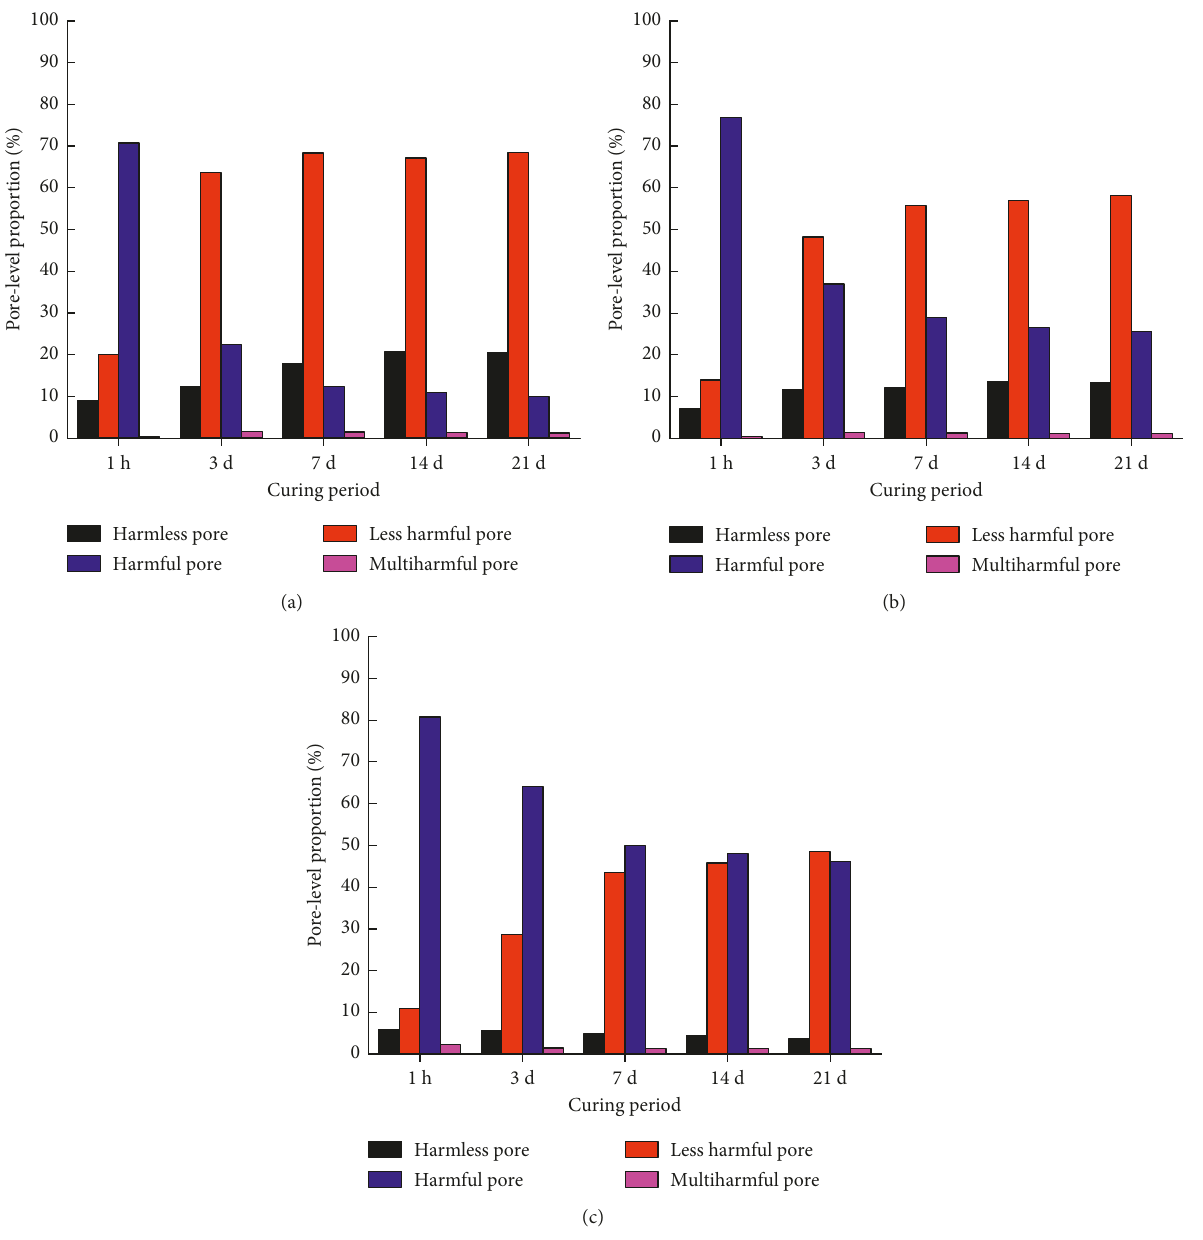
Figure 7: Pore size distributions of the filling slurries with different cement-sand ratios: (a) 1 :3, (b) 1 :5, and (c) 1: